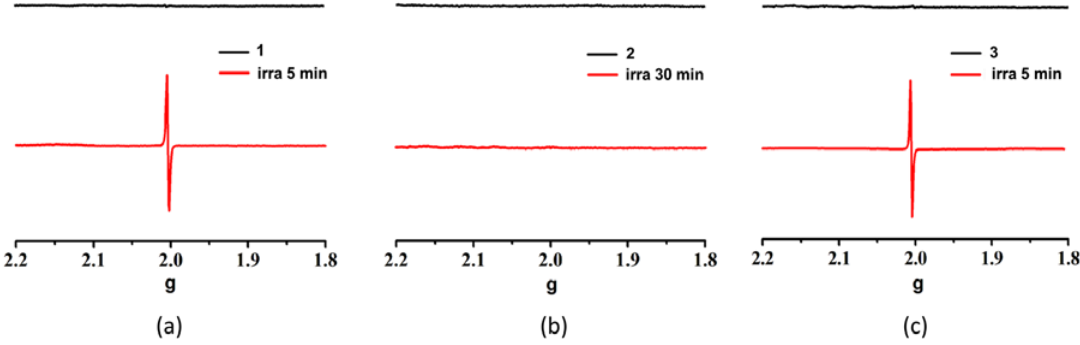
Figure 5. ESR spectra of compounds 1 ( a ), 2 ( b ), and 3 ( c ) before and after irradiation.